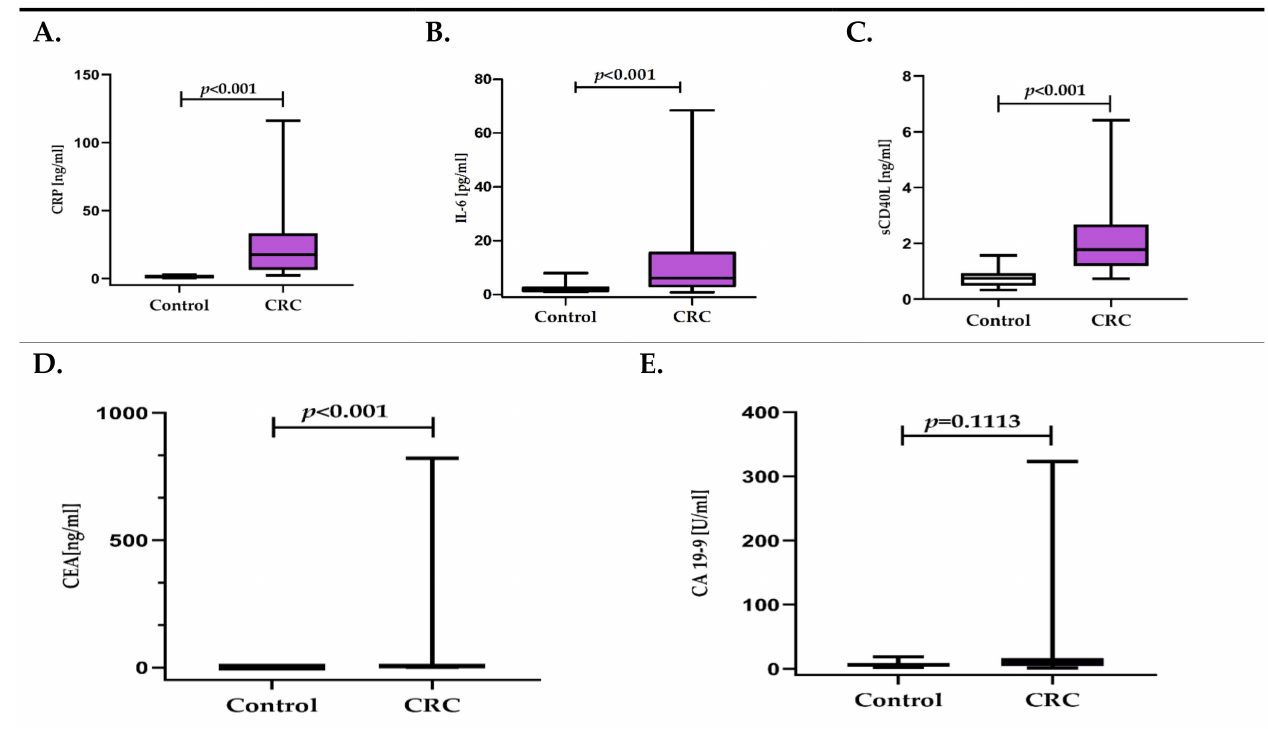
Figure 1. ( A – E ). Concentration of inflammatory response biomarkers (CRP, IL-6, sCD40L) and cancer biomarkers (CEA, CA 19-9) in colorectal cancer patients (CRC), in relation to the control